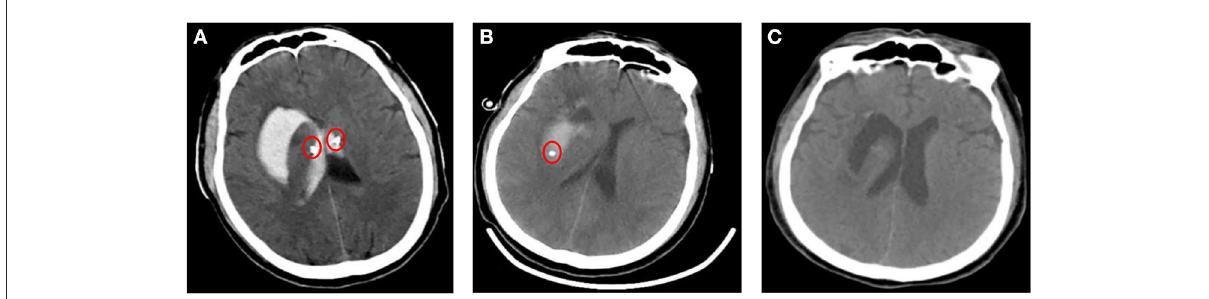
FIGURE3 Imaging findings after treatments. (A, B) Images of a cranial CT after implantation of a drainage tube (red circle) though drilling in bilateral lateral ventricle and in the right basal ganglia. (C) CT after removing the drainage tube showed normal bilateral lateral ventricles and a cavity in right basal ganglia.